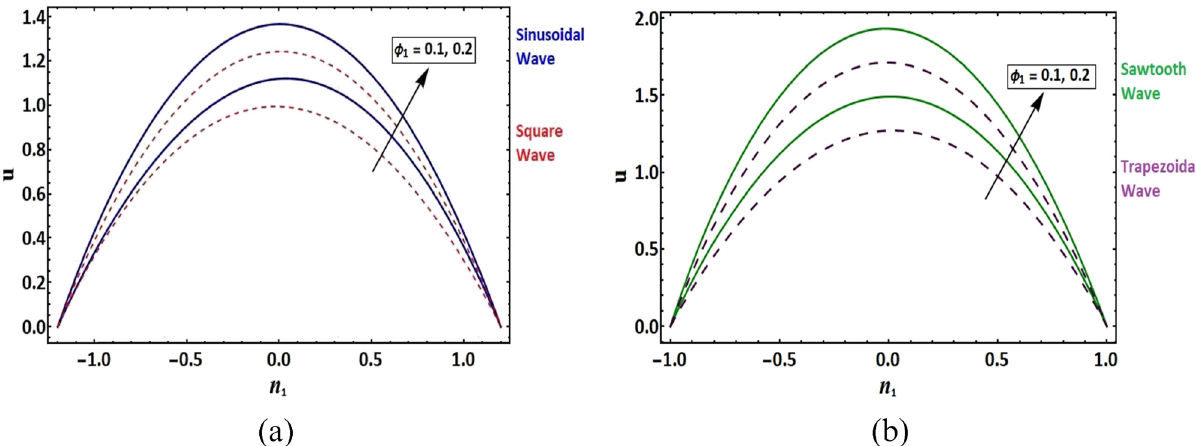
Figure 5: ( a and b ) Velocity pro fi le for λ 1 = 0.5, Sr = 0.5, A 1 = 2, Sc = 0.5, A 3 = 1, Br = 0.5, K 3 = 2, Gr = 0.4, M = 0.5, K 3, ϵ 0.2 = = , B 0.4 1 = , and B 0.2 2 = .